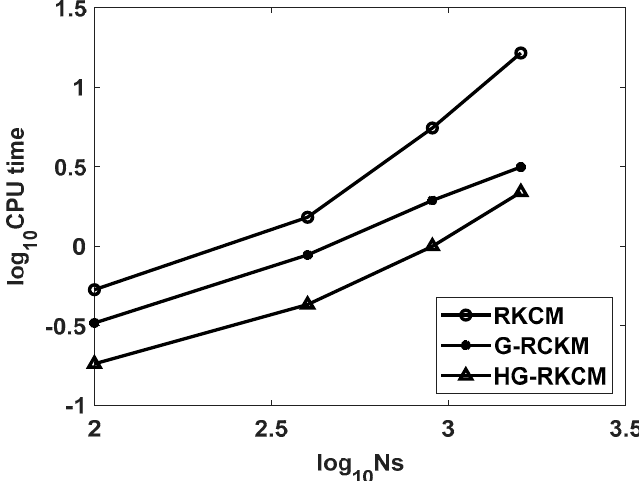
Figure 6. Comparison of CPU t ime by different methods in the square domain.